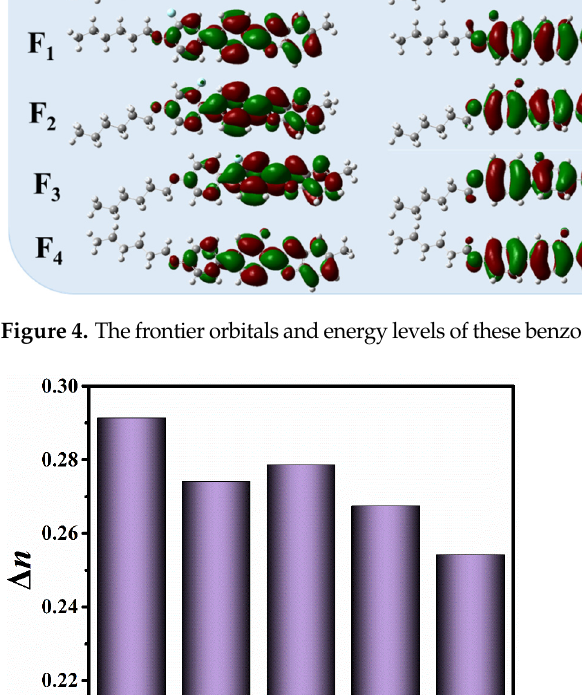
Figure 5. The birefringence values of LC mixtures at 25 ◦